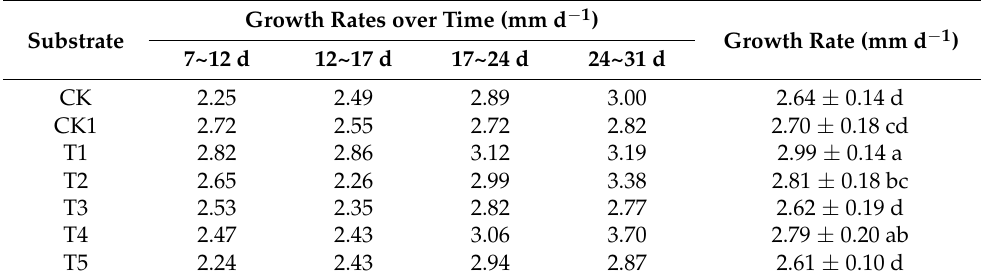
Table 1. Growth rate of P. eryngii cultivated on different substrates #